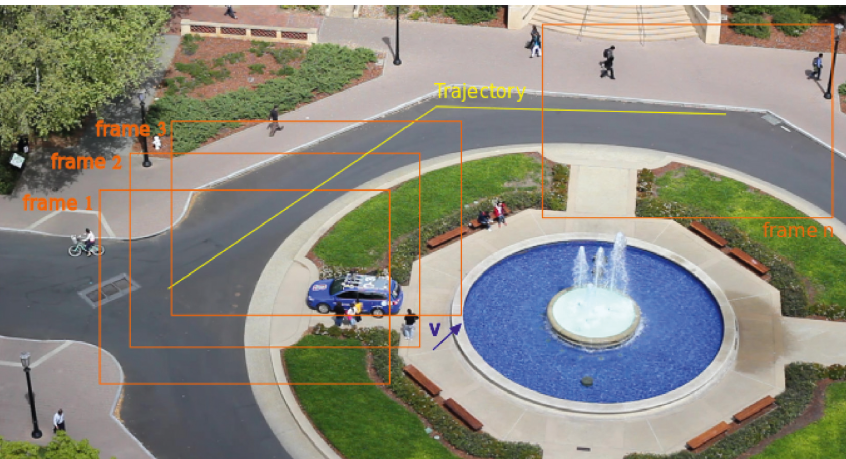
Figure 1: Construction of the synthetic panning and jitter dataset. The selected region (blue rectangles) was of 720 × 480 pixel, and the centroid of the region was translated at a velocity v (red vector) along a piecewise linear trajectory (green). This figure is a slightly modified version of Figure 1 in